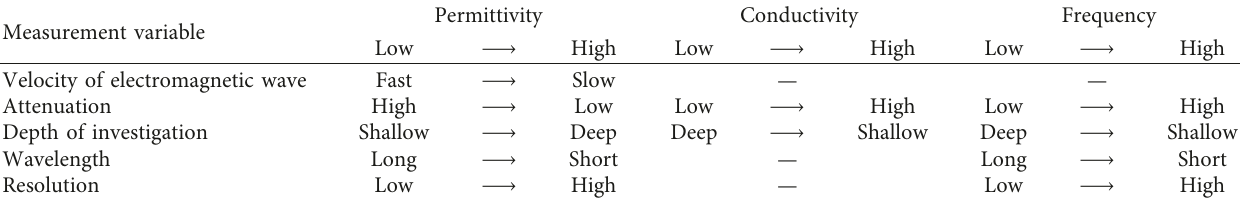
Table 1: Relationship between the variables of underground electrical characteristics, GPR exploration, and frequency. Measurement variable